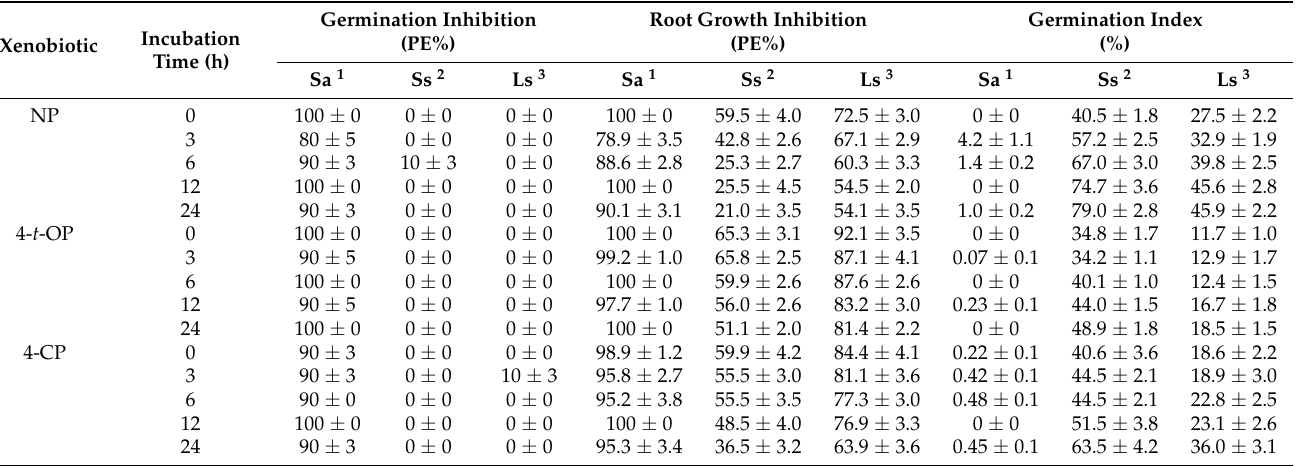
Table 2. Changes in the phytotoxicity of post-culture filtrates before and after xenobiotic biodegrada- tion